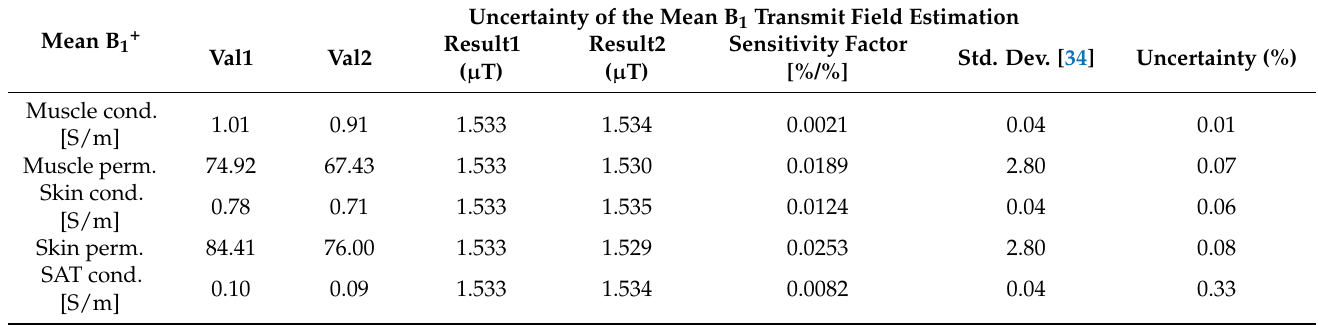
Figure 11. Current density map displayed on EEG traces in the 3D surface view. ( a ) NeoNet, ( b ) CuNet with ideal current limiting resistors, ( c ) CuNet without resistors. Table 5. Uncertainty of the mean B 1 transmit field estimation. The methods used were based on the work of Neufeld et al. [34] to evaluate the uncertainty of the quantities derived by simulation; two simulations were assessed for each parameter by assigning two different values (“Value1” and “Value2”). The first value (“Value1”) was the one used for the simulation, whereas the second value (“Value2”) was set to a realistic value that could occur from the measurement or design choice. The results obtained for each value (“Result1”, and “Result2”) were used to evaluate the sensitivity factor of the quantity evaluated (mean B 1 transmit field). The standard deviation (“Std. Dev.”) was derived from